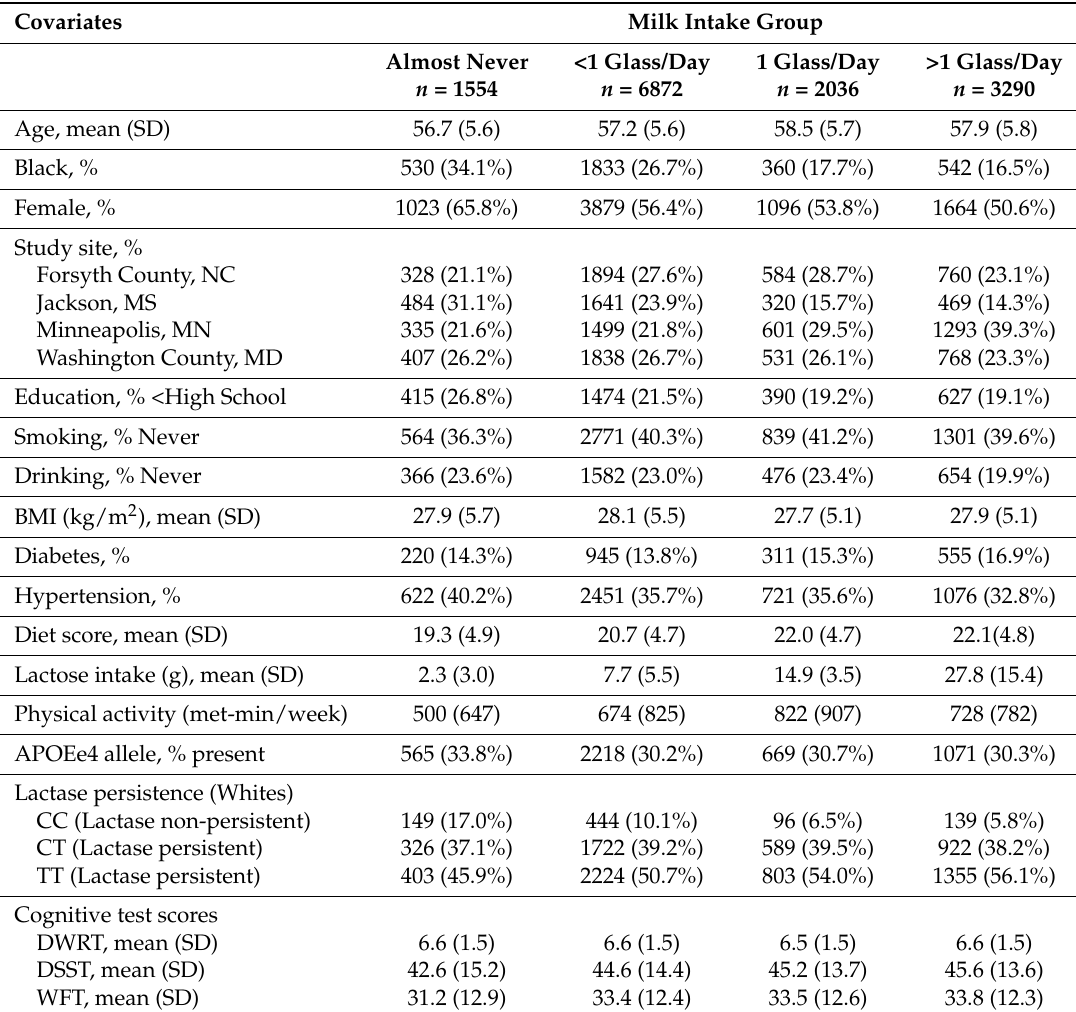
Table 1. Baseline (visit 2) characteristics of study participants by milk intake group. ARIC Study,